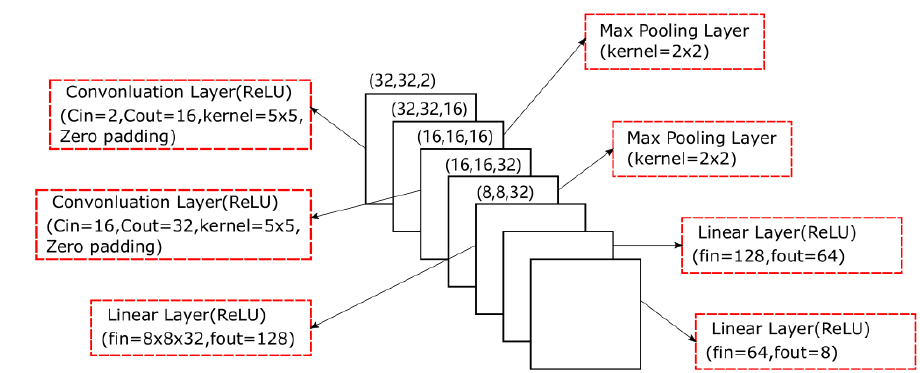
Figure 11. Structure of the CNN used in the comparison